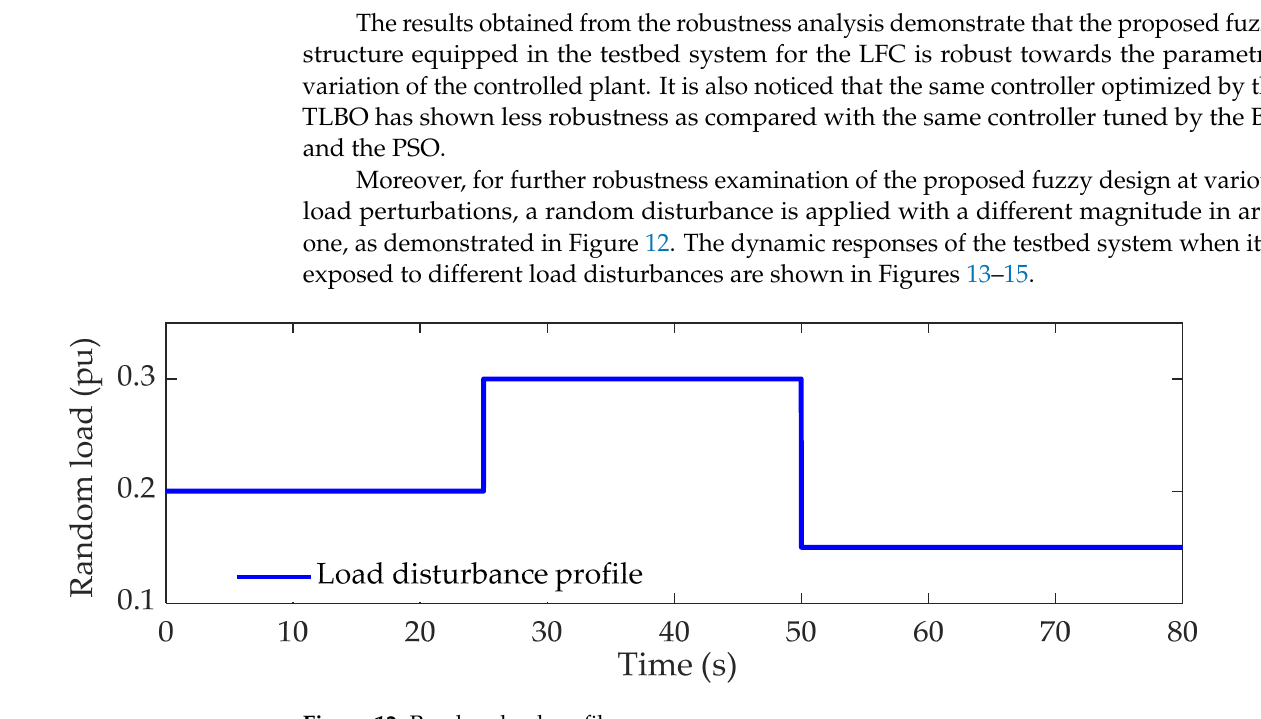
Figure 12. Random load profile.